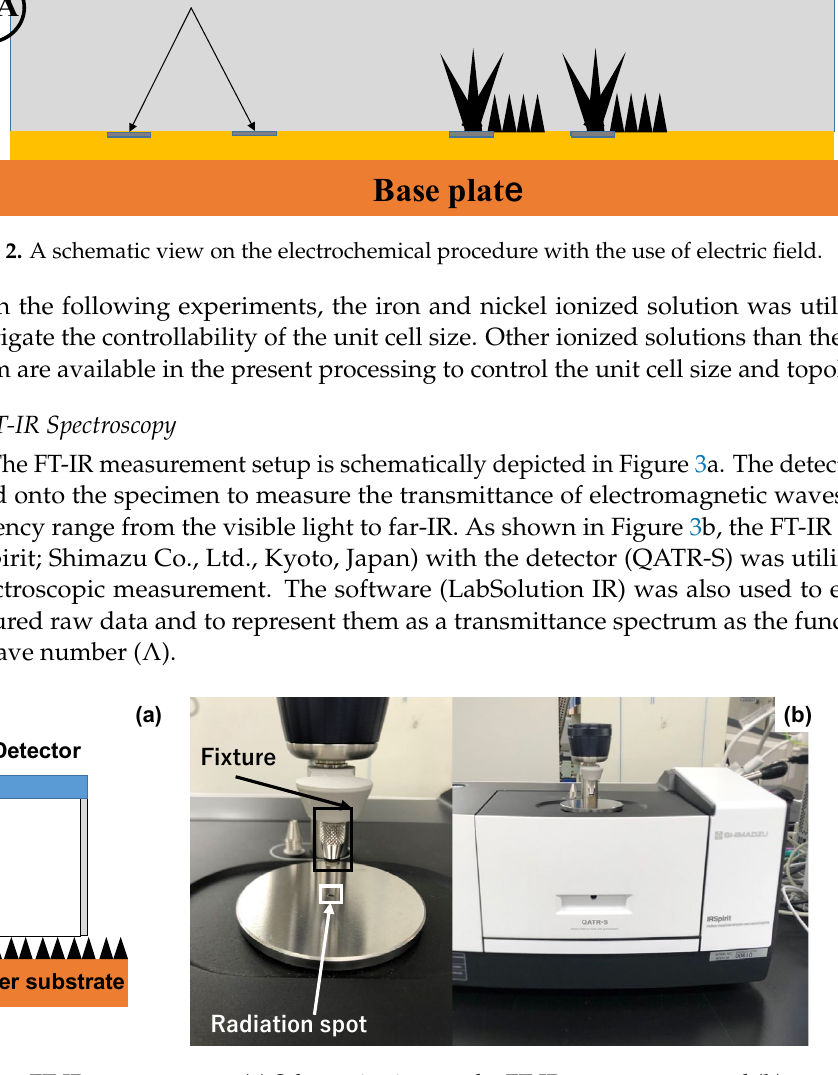
Figure 3. FT-IR measurement. ( a ) Schematic view on the FT-IR measurement and ( b ) overview on the measurement system for spectroscopic analysis.